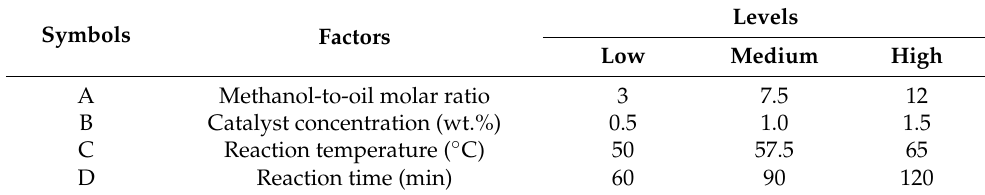
Table 2. Transesterification parameters and operating levels.